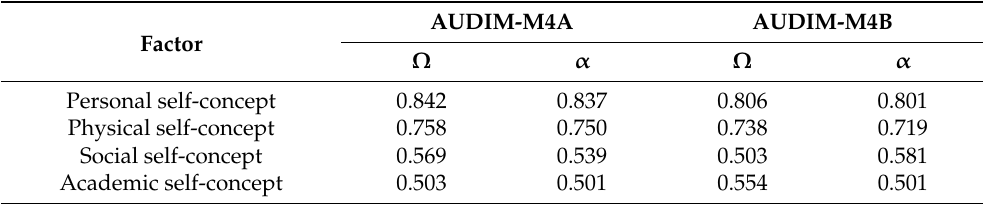
Table 3. Omega and alpha coefficients for the factors of the models AUDIM-M4A y AUDIM-M4B.